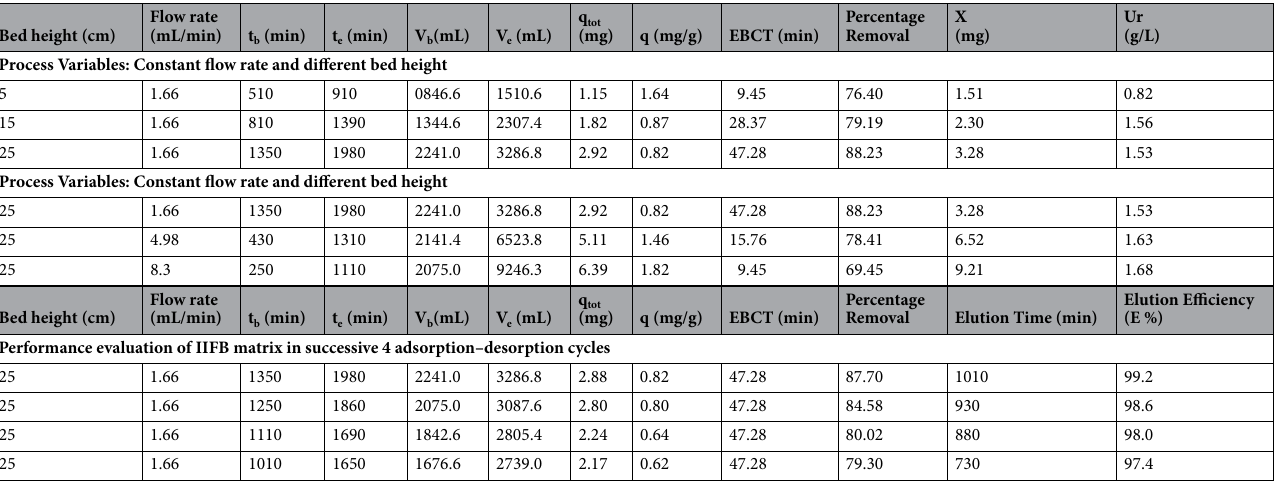
Table 5. Sorption data for As(III) sorption in up-flow packed-bed bioreactor containing IIFB discs as